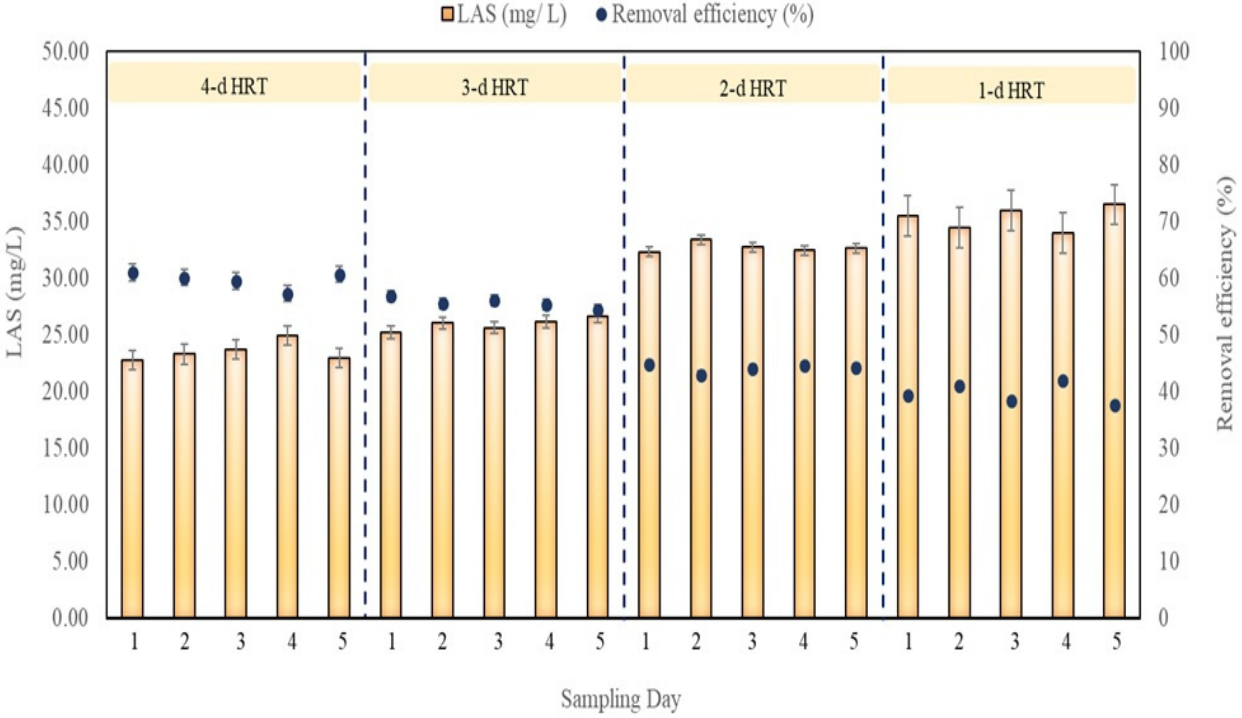
Figure 2. Total chemical oxygen demand (TCOD) concentrations and removal efficiencies from MEC at different HRTs.